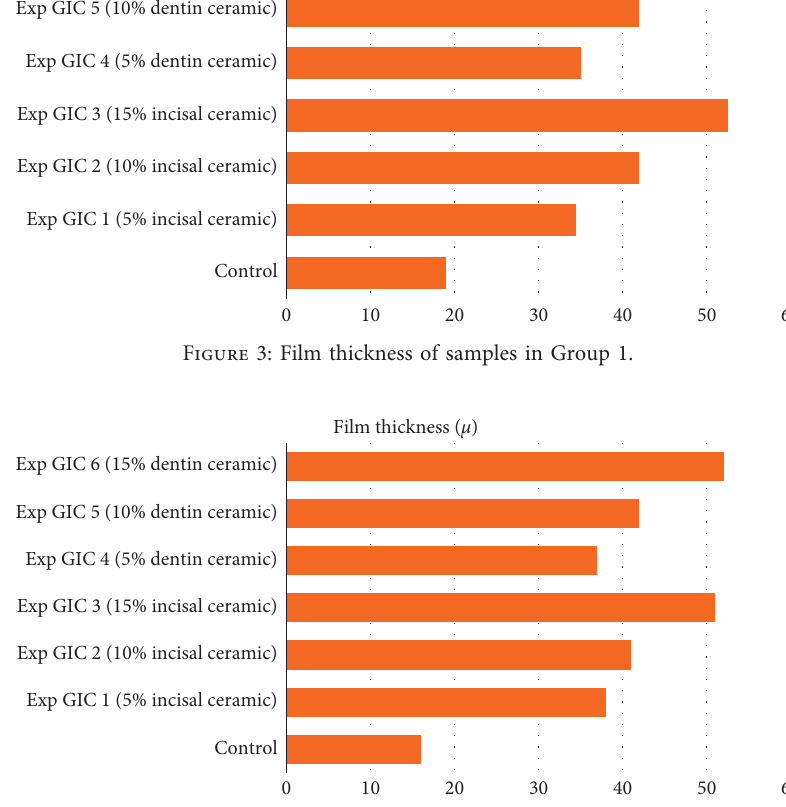
Figure 4: Film thickness of samples in Group 2.